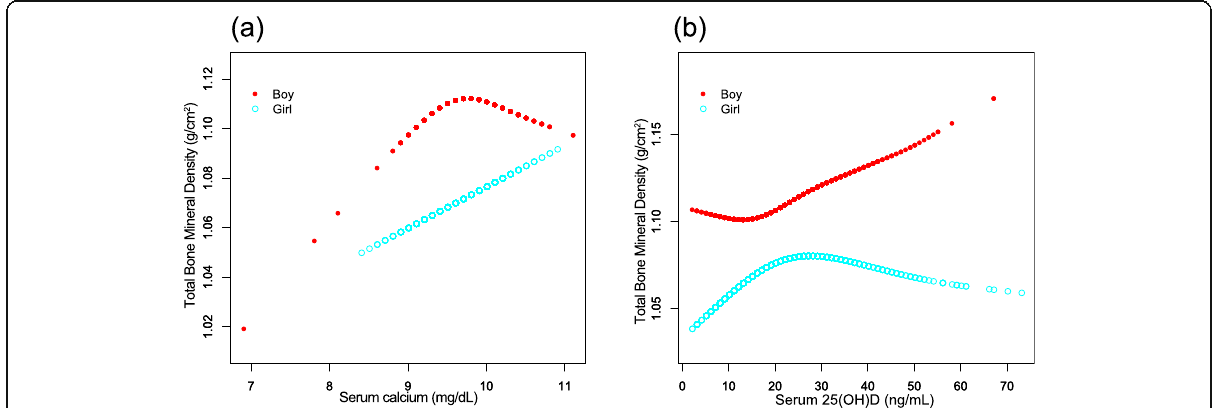
Fig. 3 The associations between serum calcium ( a ), serum 25(OH)D ( b ) and total bone mineral density stratified by gender. Adjusted for age, race/ethnicity, income to poverty ratio, education, physical activity, body mass index, calcium supplementation